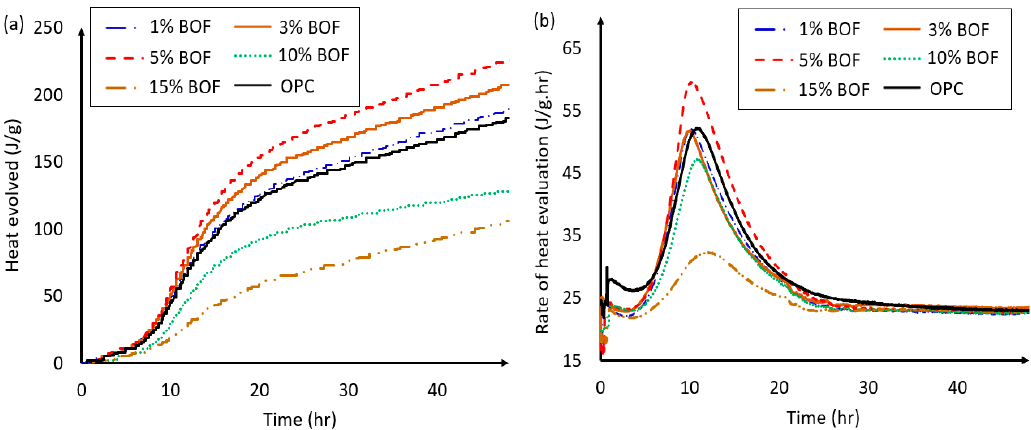
Figure 7. ( a ) Heat evolved and ( b ) rate of heat evaluation of the semi-adiabatic calorimetry tests for OPC and BOF-enhanced cement with 1%, 3%, 5%, 10%, and 15% BOF. Table 3. Initial and final setting times for OPC and BOF-enhanced cement mortars (all in min). Specimens Initial Final Ordinary Portland cement (OPC) 150